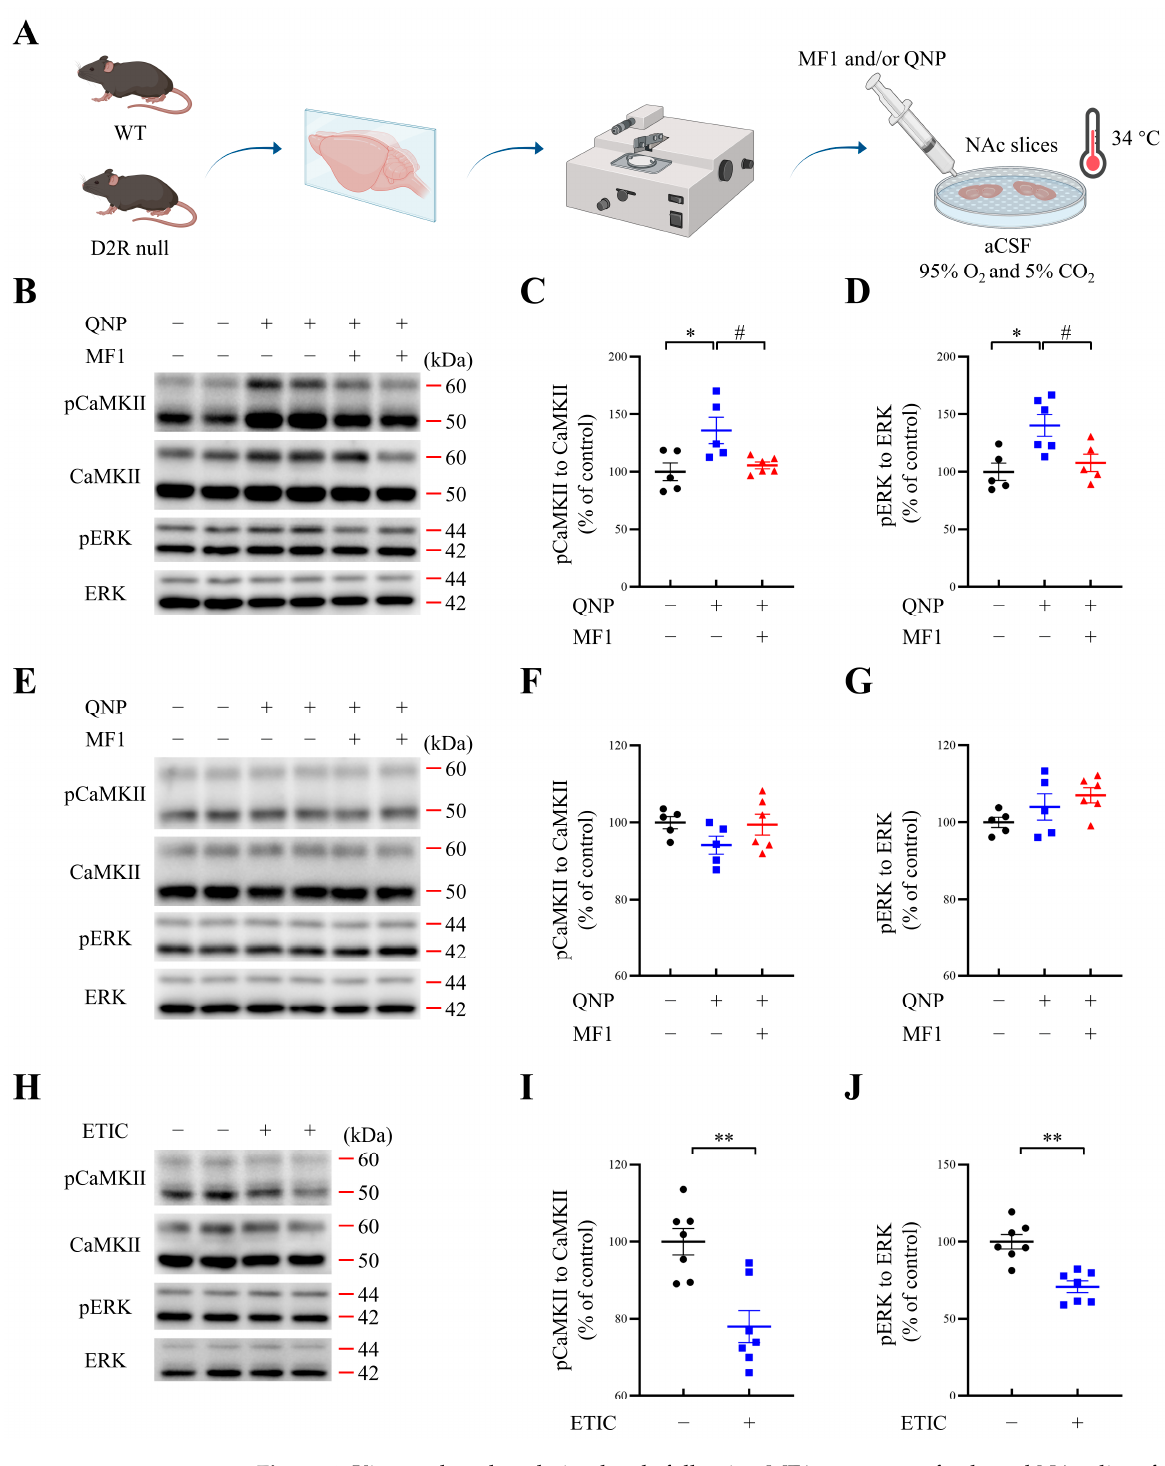
Figure 4. Kinase phosphorylation levels following MF1 treatment of cultured NAc slices from WT and D2R null mice. ( A ) Experimental illustration of mouse brain slice cultures. ( B – D ) Representative images and quantitative data for autophosphorylated CaMKII, CaMKII, phosphorylated ERK, and ERK in cultured NAc slices from WT mice. QNP stimulation signi fi cantly increased CaMKII autophosphorylation and ERK phosphorylation levels; however, these increases were inhibited by MF1 pretreatment ( n = 5–6 per group). * p < 0.05 vs. vehicle-treated group; # p < 0.05 vs. QNP-treated group. ( E – G ) Representative images and quantitative data for autophosphorylated CaMKII, CaMKII, phosphorylated ERK, and ERK in cultured NAc slices from D2R null mice. Robust changes in levels of CaMKII autophosphorylation and ERK phosphorylation were not observed following QNP and MF1 pretreatment ( n = 5–6 per group). ( H – J ) Representative images and quantitative data for autophosphorylated CaMKII, CaMKII, phosphorylated ERK, and ERK in cultured NAc slices